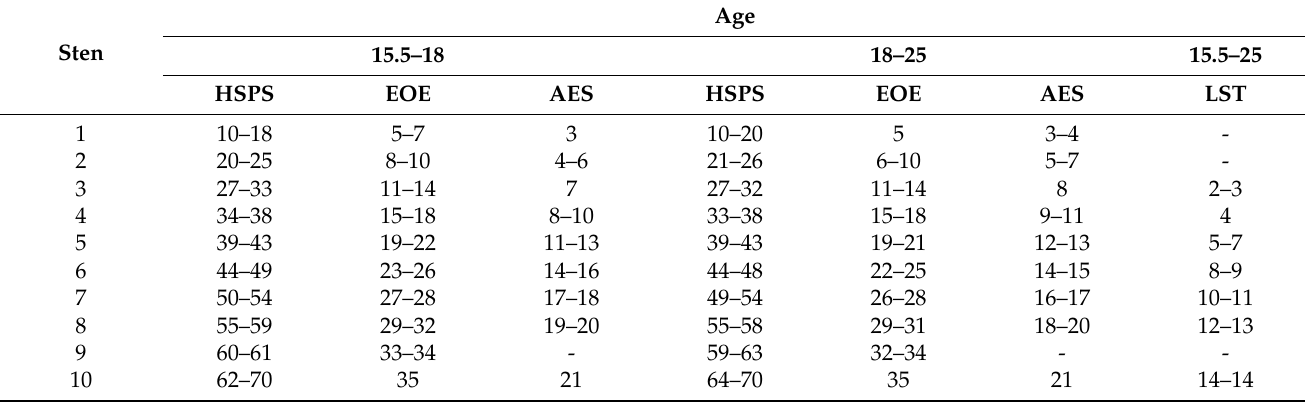
Table 7. Sten standards for people aged